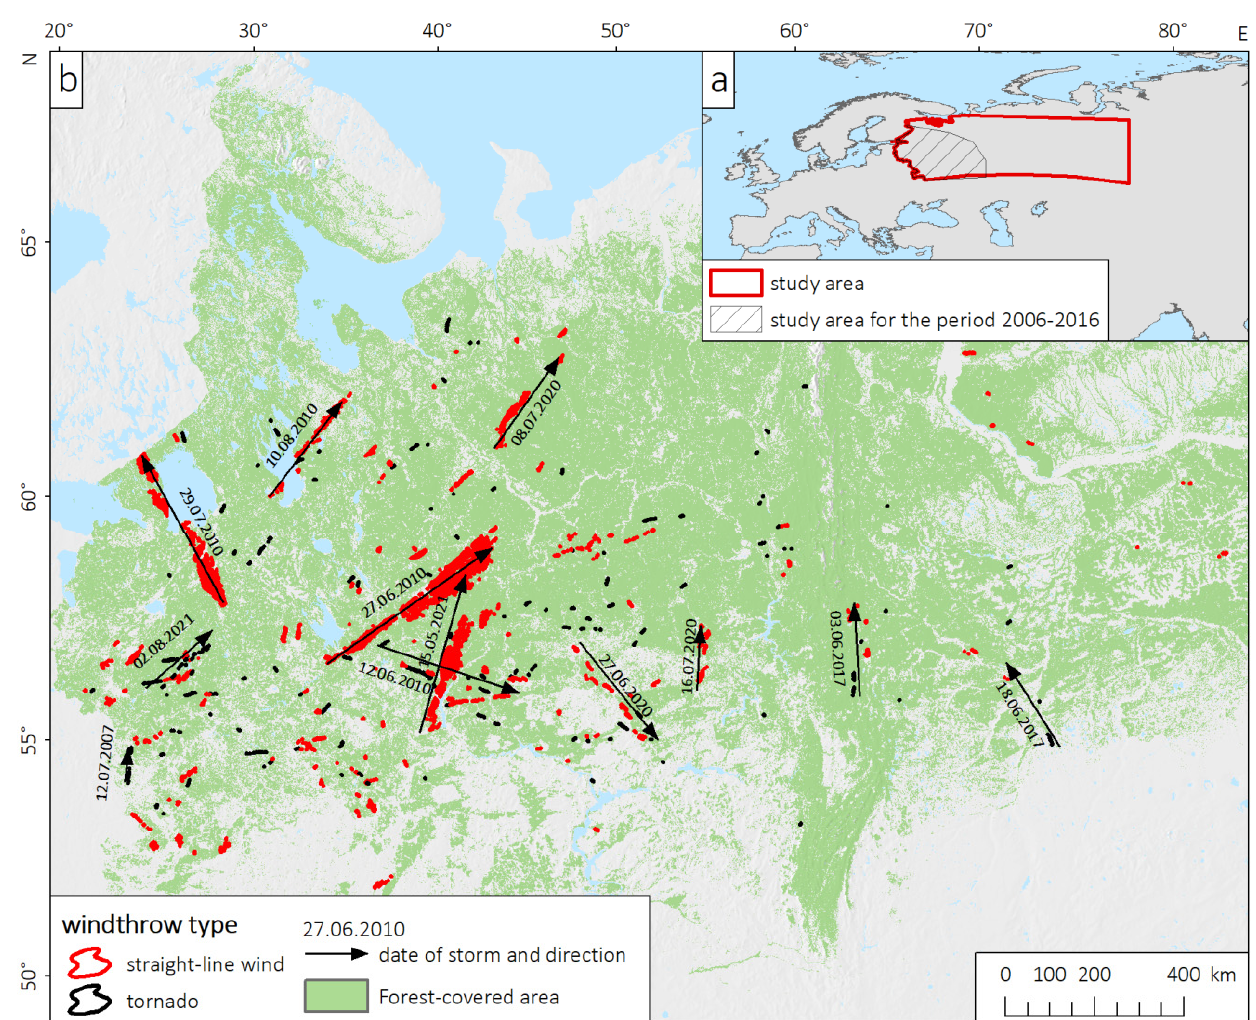
Figure 1. ( a )—Geographical location of the study area, and ( b )—the analyzed sample of windthrow events (shown with red for straight-line winds and black for tornadoes). The dates and propagation direction of the most severe storms are also shown.